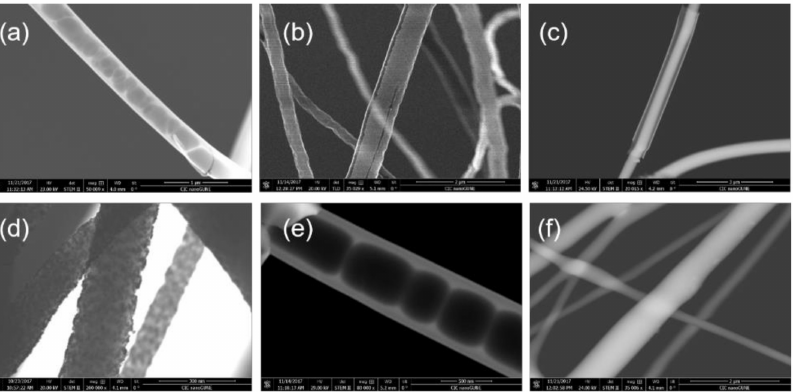
Figure 5. STEM images of: CA fibres coated with ( a ) Al 2 O 3 and ( b ) ZnO, PES fibres coated with ( c ) Al 2 O 3 and ( d ) ZnO, and PLLA fibres coated with ( e ) Al 2 O 3 and ( f ) ZnO. The target thickness in all cases was 30